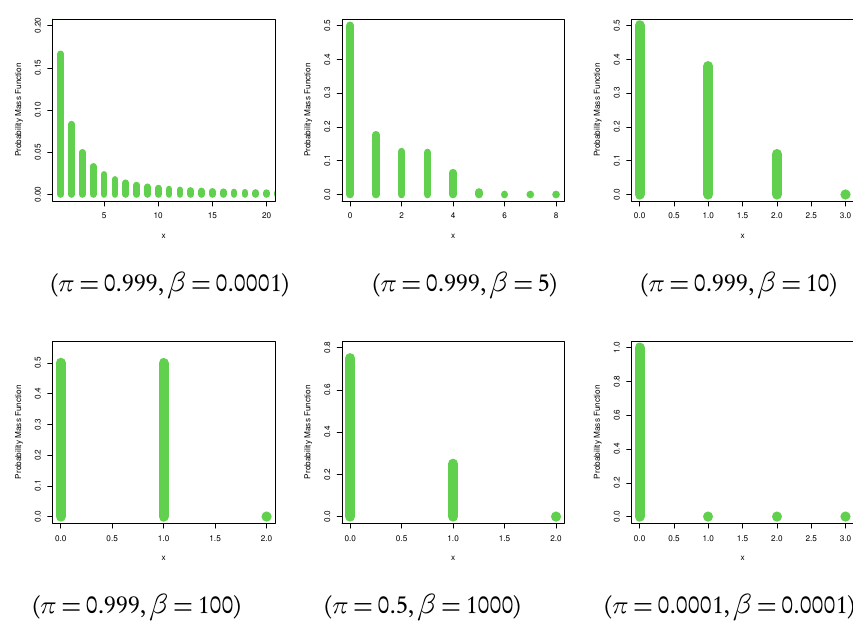
Figure 1 – The PMF plots of the DGBH